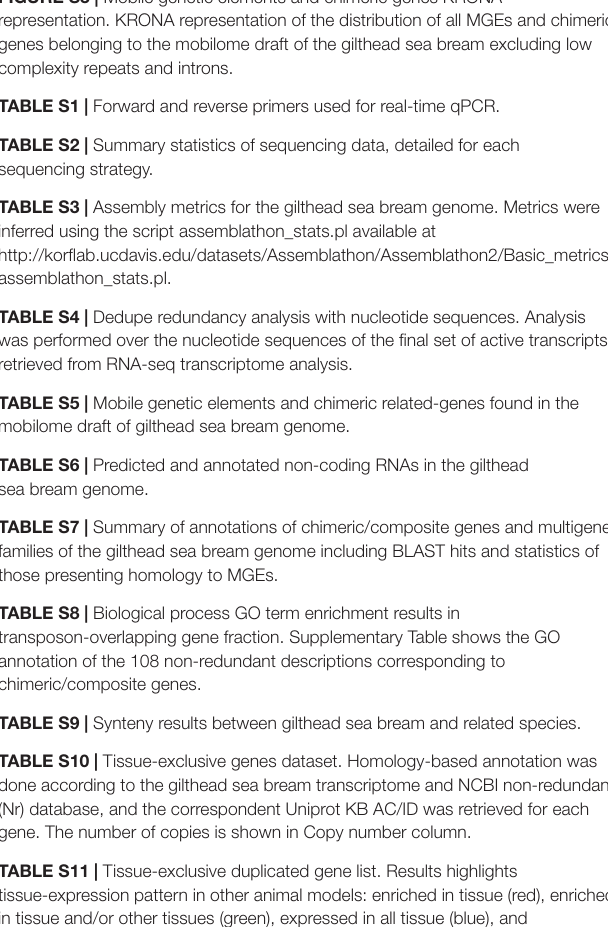
FIGURE S2 | Reconstructed gilthead sea bream super-scaffolds. All scaffolds (1.87–12.05 Mb) were anchored to the gilthead sea bream chromosomes (2 n = 48 ). Scaffolds are listed at the right side of each super-scaffold, and a nucleotide position of reference for the browser is marked in the left side. A genome browser to access and navigate the super-scaffold is available at www.nutrigroup-iats.org/seabreamdb. FIGURE S3 | Mobile genetic elements and chimeric genes KRONA representation. KRONA representation of the distribution of all MGEs and chimeric genes belonging to the mobilome draft of the gilthead sea bream excluding low complexity repeats and introns. TABLE S1 | Forward and reverse primers used for real-time qPCR. TABLE S2 | Summary statistics of sequencing data, detailed for each sequencing strategy. TABLE S3 | Assembly metrics for the gilthead sea bream genome. Metrics were inferred using the script assemblathon_stats.pl available at